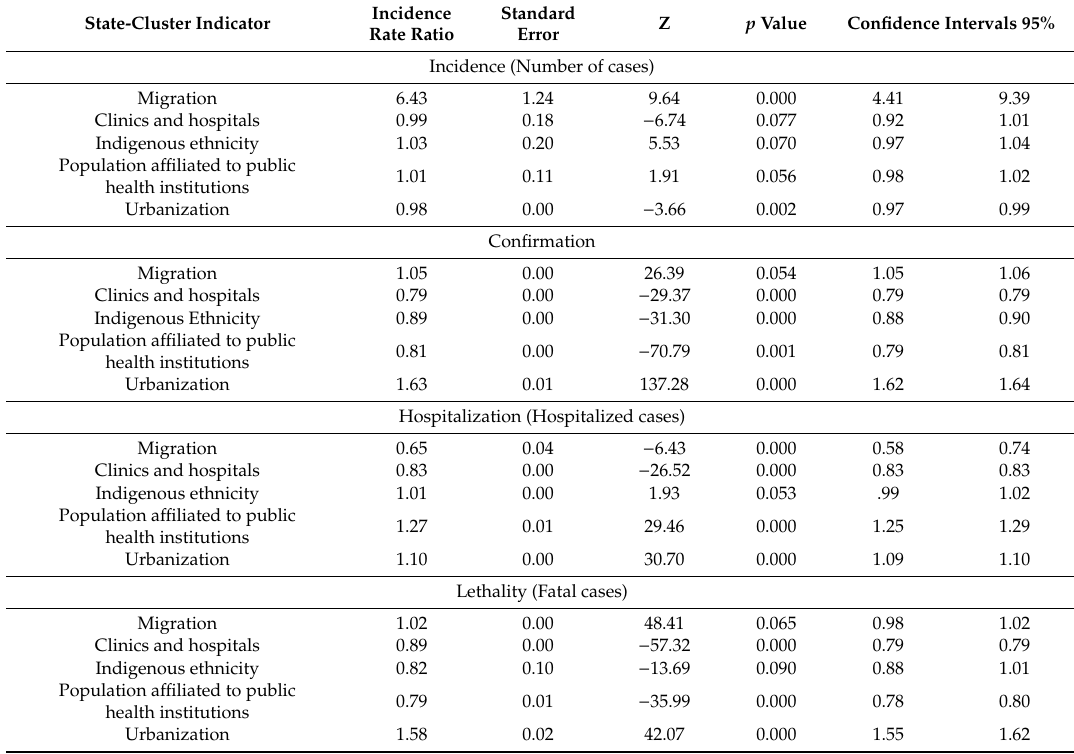
Table 2. COVID-19 incidence, confirmation, hospitalizations, and lethality by state-cluster population indicators in Mexico between 28 February and 21 April ( n = 17,763 in 32